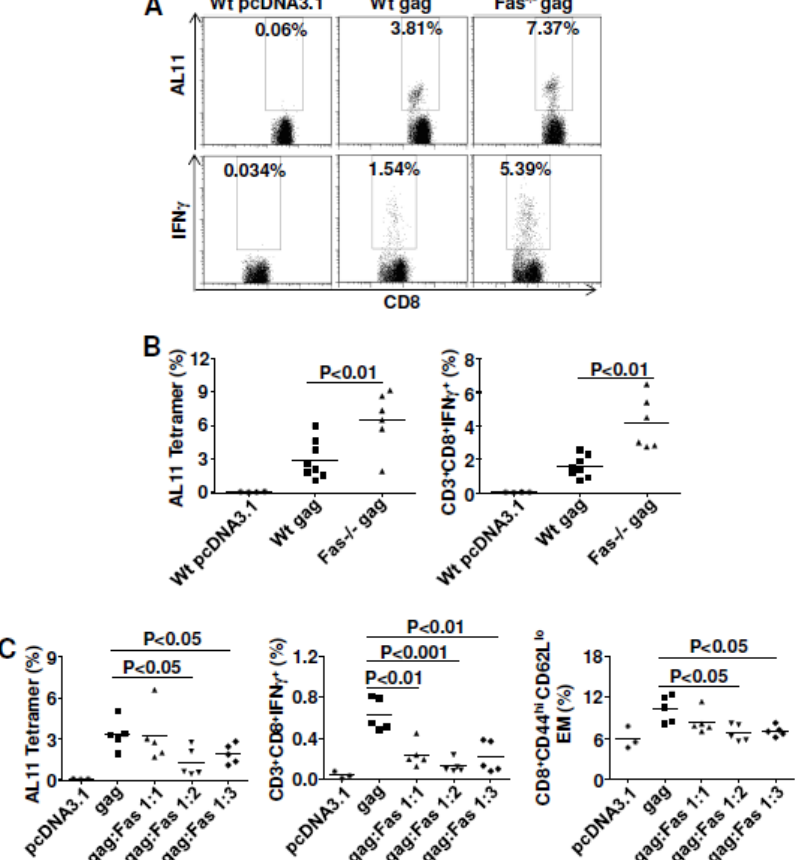
Figure 1. Fas gene-expression plays a negative role in regulating cell-mediated immune (CMI) responses induced by DNA vaccination. ( A and B ) CMI were significantly improved for both quantity and quality in Fas knock-out (KO) mice. Wild type C57BL/6 mice and their cognate KO mice were immunized with 10 μg plasmid pJ603-gag at day 0 and day 28. Mice were euthanized 10 days after the last immunization and splenocytes were prepared for CMI assay; ( A ) Representative plots were shown for tetramer staining (top) and intracellular cytokine staining (bottom); ( B ) Summary data for tetramer staining (left) and intracellular cytokine staining (right); ( C ) Overexpression of Fas seriously impaired cellular immune responses induced by DNA vaccination. Wild-type C57BL/6 mice were immunized with 2 μg plasmid pJ603-gag and different doses of plasmid pJ603-Fas at day 0 and day 14. Mice were euthanized 10 days after the last immunization and splenocytes were prepared for CMI assays; Data in A and B are collected from one single experiment ( n= 8 except for control group where n= 4). Two Fas KO mice died before analysis; Data in C are representative of two independent experiments with similar results ( n= 5 except for control group where n= 3). pcDNA3.1 was added to make sure all the vaccinated mice received the same quantity of